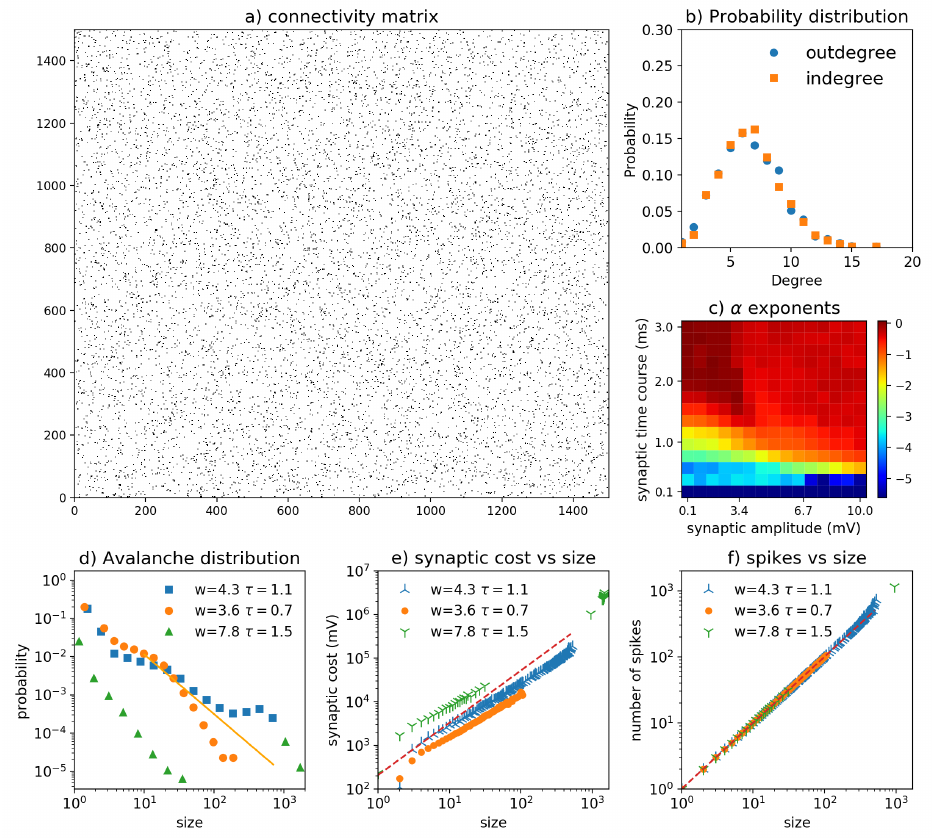
Figure 8. Metabolic costs in Erdos–Renyi network. ( a ) The connectivity matrix shows no clustering. ( b ) Indegree and outdegree conectivity. ( c ) Heatmap of α exponents reveals no reliable critical dynamics. ( d ) Avalanche distributions for: w = 4.3 mV and τ = 1.1 ms; w = 3.6 mV and τ = 0.7 ms; w = 7.8 mV and τ = 1.5 ms. Distributions do not follow power-law scaling. The solid line represents α = − 1.56. ( e ) Synaptic cost vs. size. ( f ) Number of spikes. For w = 3.6 mV and τ = 0.7 ms pair, the system shows only local activation, for high values w = 7.8 mV and τ = 1.5 ms, the system shows a poor range of avalanche sizes, either small or global avalanches. For intermediate values, w = 4.3 mV, and τ = 1.1 ms, the system shows a wide range of avalanche sizes with reduced synaptic